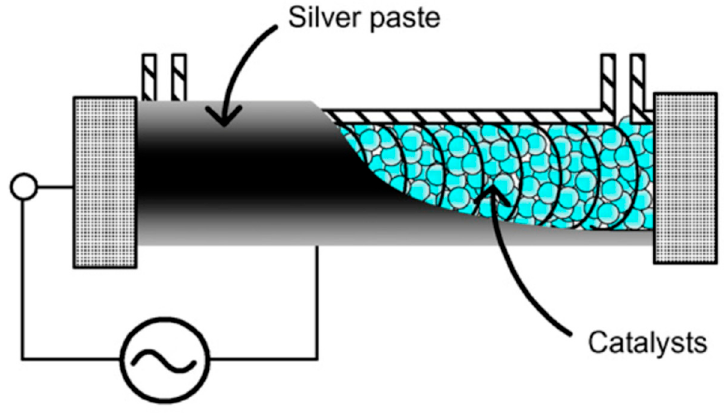
Figure 16. Schematic diagram of the plasma-driven catalyst (PDC) reactor. Reprinted with permission from [196], 2007, Elsevier Ltd.